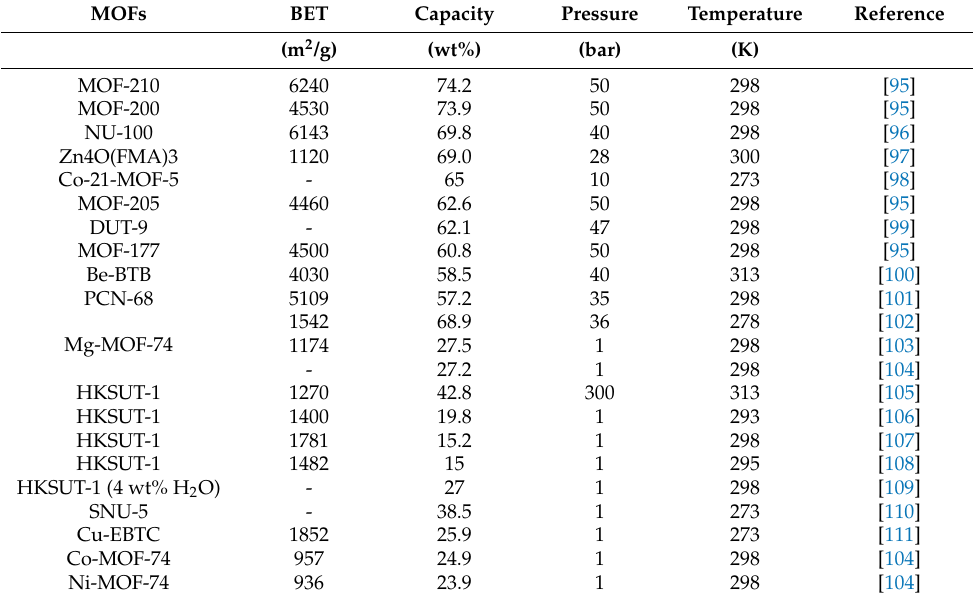
Table 1. High pressure and low pressure CO 2 adsorption in specific metal organic frameworks within 273–313